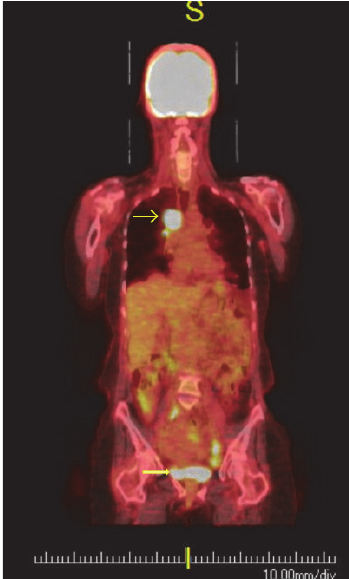
Figure 2: Whole body positron emission tomography-computed tomography (PET-CT) scan highlighted the abdominal wall mass (thick arrow) as well as left inguinal, paratracheal, and hilar (thin